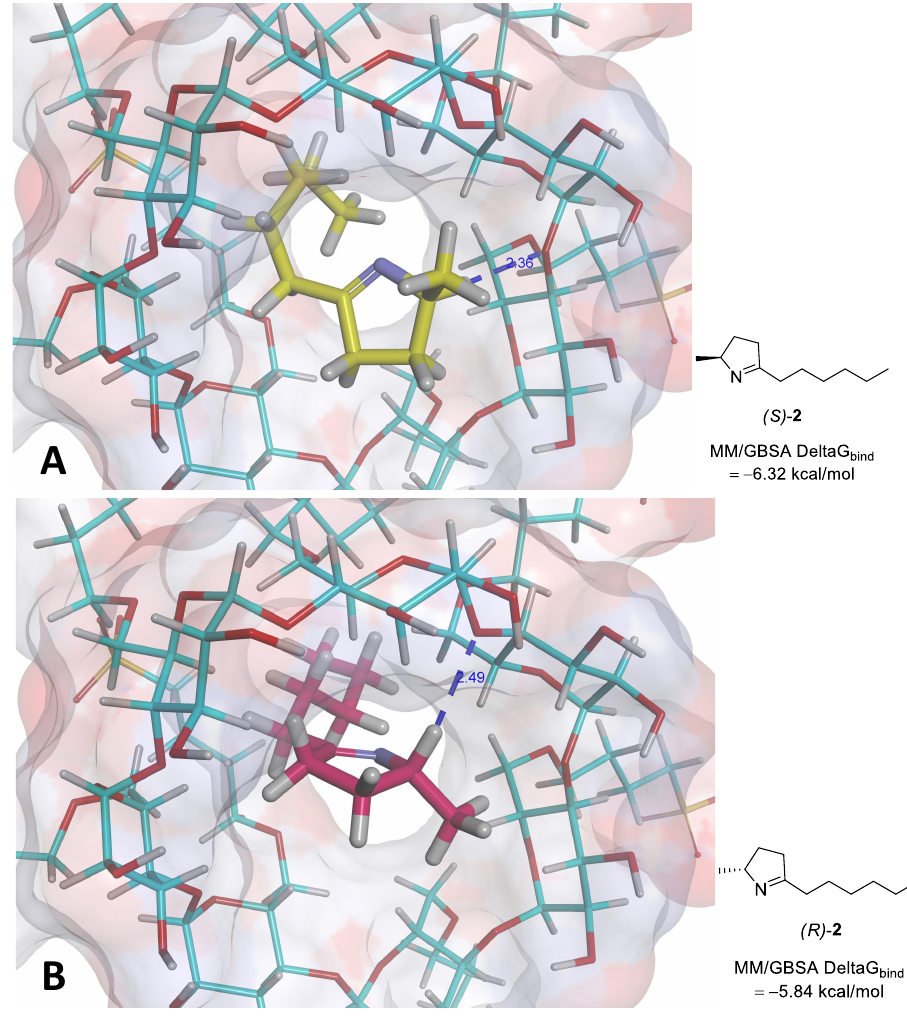
Figure 3. Proposed binding modes for the ( R )- and ( S )-enantiomers of 5-hexyl-2-methyl-3,4-dihydro- 2 H -pyrrole 2 with the sulfobutylether- β -cyclodextrin, highlighting the main intermolecular inter- actions and the corresponding binding free energies predicted using the Molecular Mechanics Generalized Born Surface Area (MM/GBSA) method: ( A ) ( S )-pyrroline (carbon atoms in yellow; weak hydrogen bond of 2.36 Å); ( B ) ( R )-pyrroline (carbon atoms in magenta; weak hydrogen bond of 2.49